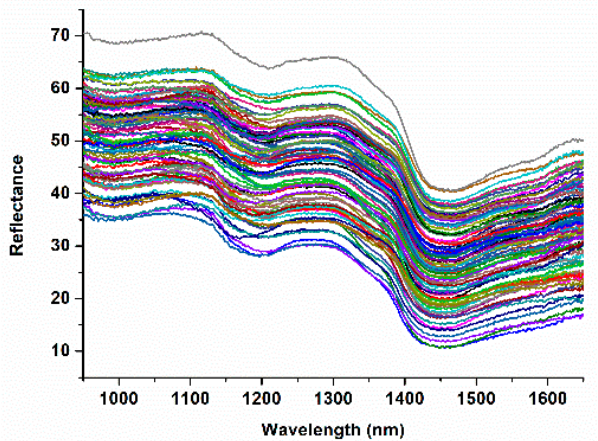
Figure 1. The NIR spectra of rice grain with di ff erent moisture content.